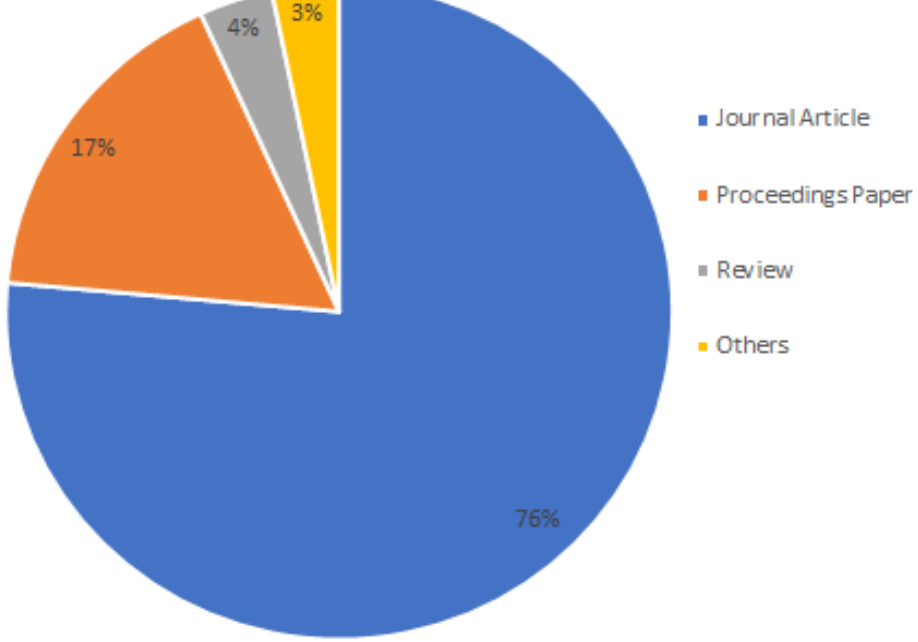
Figure 1. Type of publications on “air pollution and machine learning” .